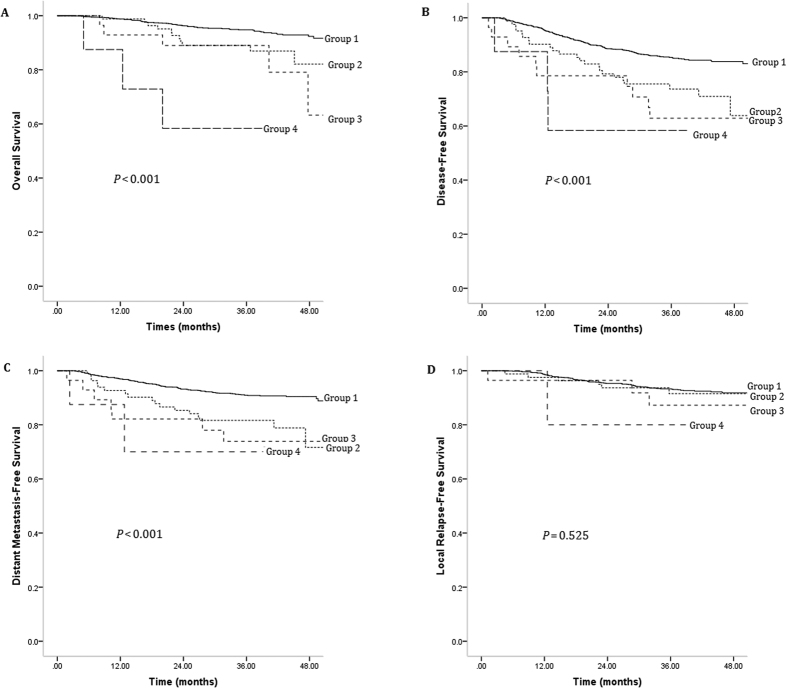
Kaplan–Meier survival curves showing overall survival rates (A), disease-free survival rates (B), distant metastasis–free survival rates (C) and local relapse–free survival rates (D) in nasopharyngeal carcinoma patients grouped according to pre- and post-treatment serum levels of lactate dehydrogenase (LDH). Group 1: normal pre- and post-treatment serum LDH levels, group 2: high pre-treatment and normal post-treatment plasma LDH levels, group 3: normal pre-treatment and high post-treatment plasma LDH levels, and group 4: high pre- and post-treatment plasma LDH level.